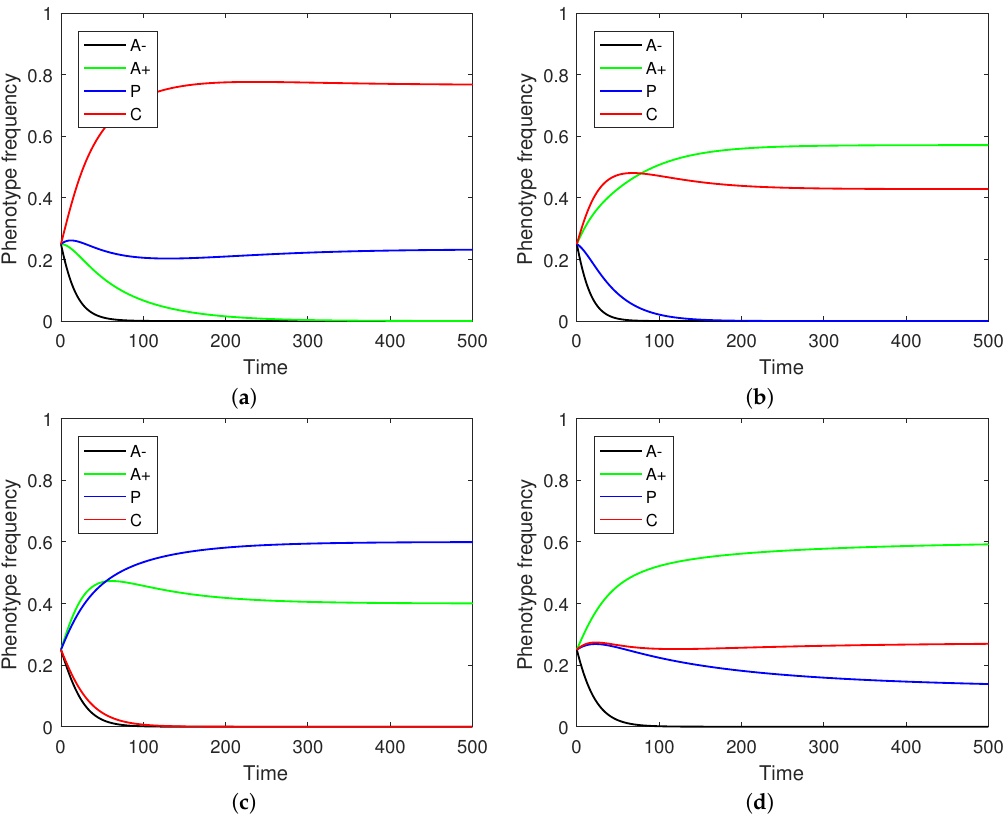
Figure 3. Equilibria between phenotypes under continuous replicator dynamics. In all figures: a = 0.02, b = 0.04. ( a ) Cytotoxic and proliferative equilibrium. Parameters: c = 0.08, d = 0.06, e = 0.15, f = 0.1, g = 0.06; ( b ) Angiogenic and cytotoxic equilibrium. Parameters: c = 0.08, d = 0.1, e = 0.15, f = 0.1, g = 0.05; ( c ) Proliferative and angiogenic equilibrium. Parameters: c = 0.01, d = 0.1, e = 0.06, f = 0.05, g = 0.06; ( d ) Angiogenic, cytotoxic, and proliferative equilibrium. Parameters: c = 0.01, d = 0.1, e = 0.12, f = 0.05, g =